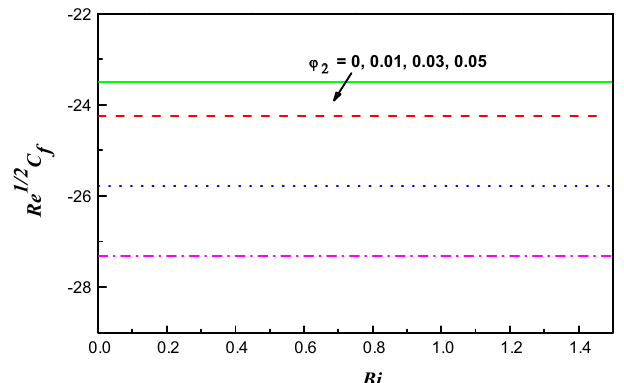
Figure 18. Re 1 / 2 C f Variation vs. Bi with ϕ 2 .